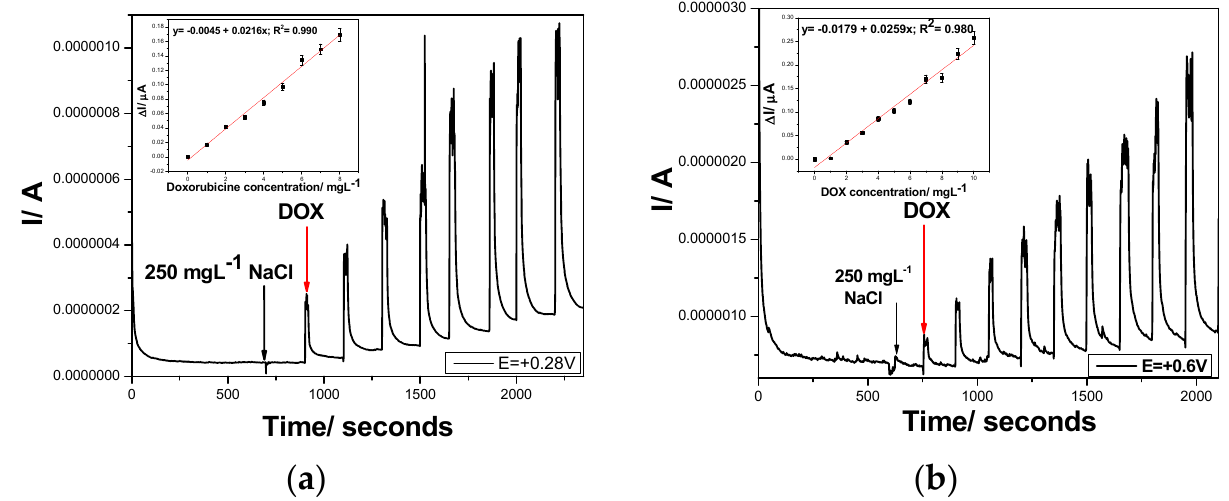
Figure 12. Chronoamperograms (CAs) recorded with the Cu/GRQD/CNT composite electrode in 0.1 M NaOH supporting electrolyte and in the presence of various doxorubicine concentrations: 1–8 mg · L − 1 for the detection potential level of: ( a ) E = +0.28 V vs. Ag/AgCl. Inset: Calibration plots of current vs. DOX concentration; ( b ) E = +0.6 V vs. Ag/AgCl. Inset: Calibration plots of current vs. DOX concentration.